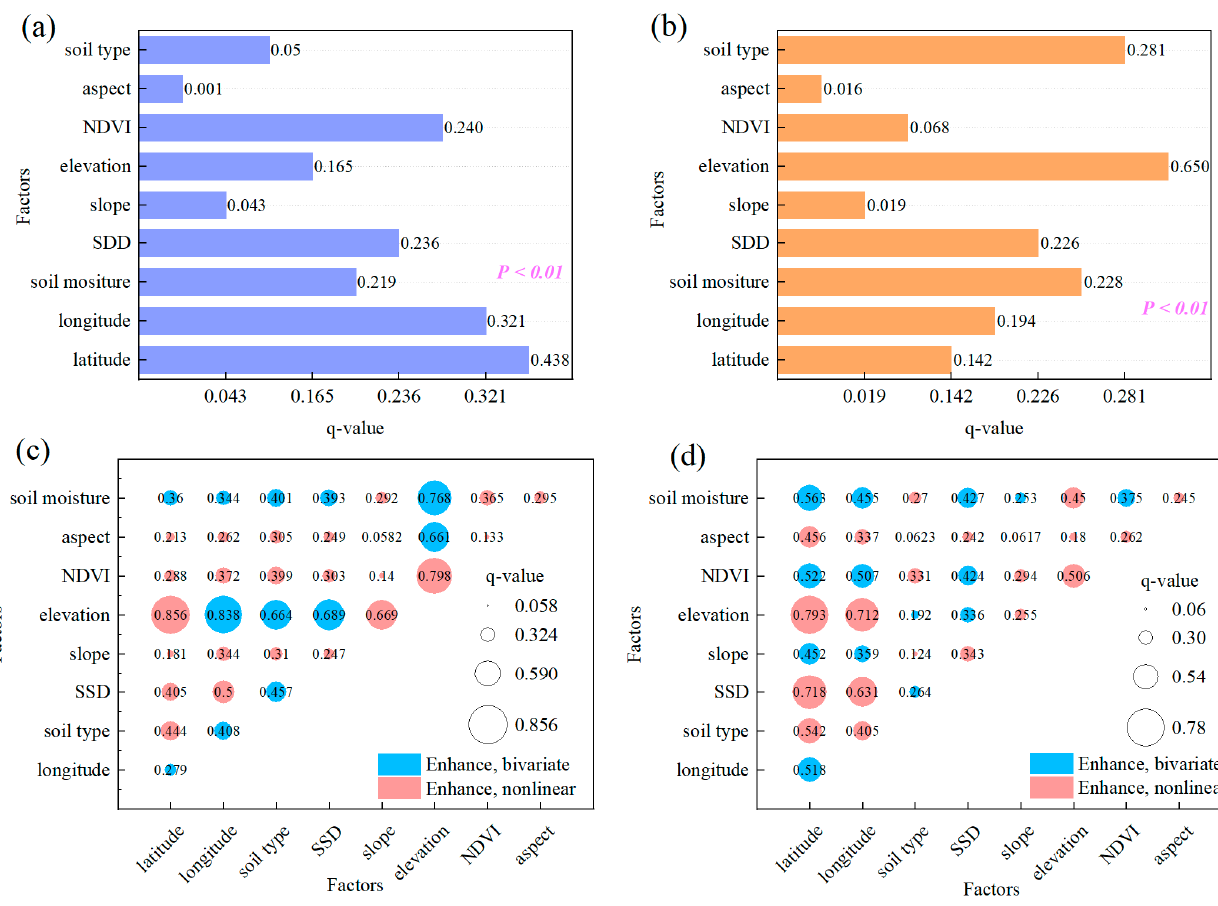
Figure 6. Results of factor detector and interaction detector of GeoDetector in the QTEC: ( a , c ) factor detector results and interaction detector results for GFI, respectively; ( b , d ) factor detector results and interaction detector results for GTI, respectively.